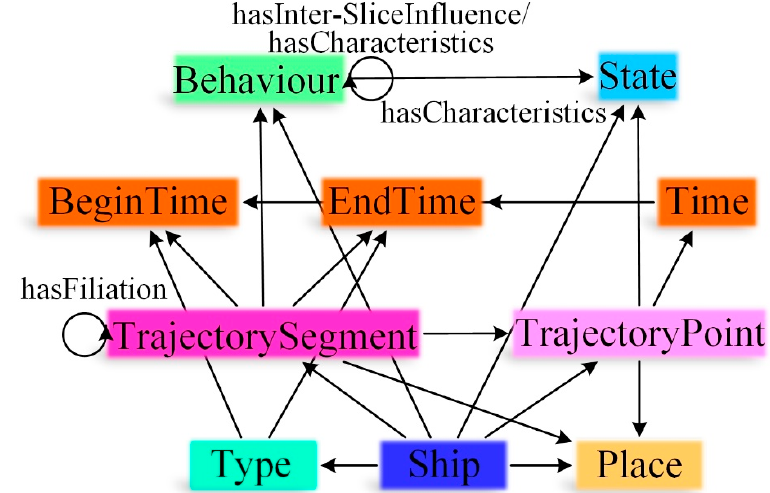
Figure 1. Core Classes and Properties of semantic network. The un-labelled arrows mean that there are general properties between the two classes, for example, the property between Ship and State is has State , and the property between Ship and Place is at Place . Begin Time and End Time are subclasses of Time .